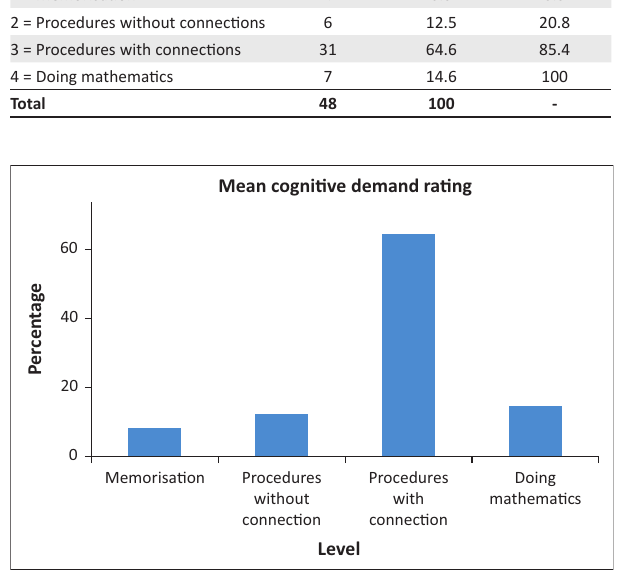
FIGURE 2: Bar graph of the mean cognitive demand rating of probability and counting learning tasks in the digital textbook by probability and counting principles